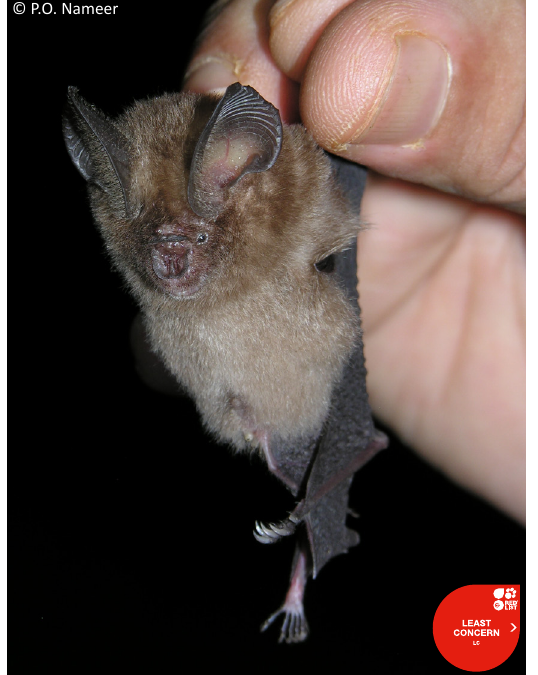
Image 9. Dusky Leaf-nosed Bat Hipposideros ater